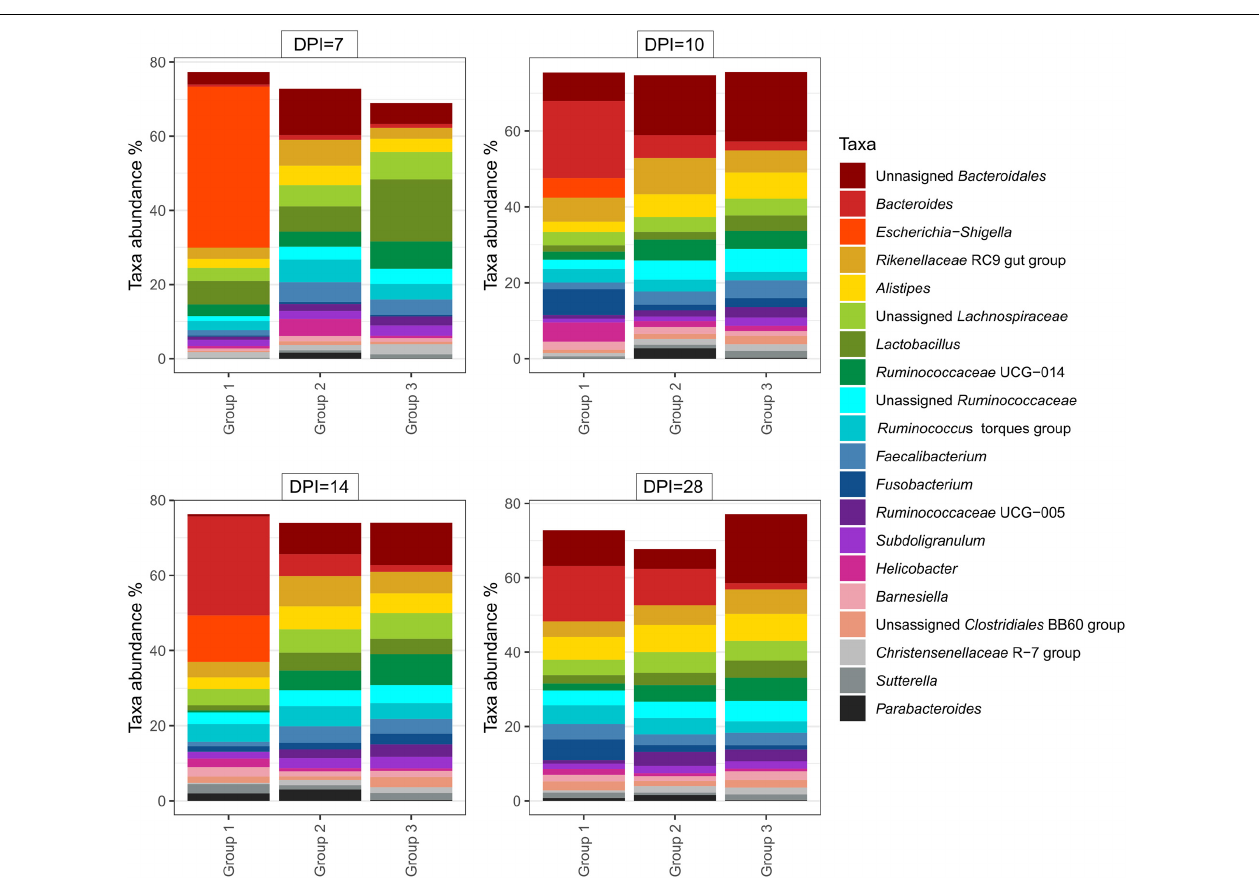
FIGURE 5 | Relative amount (%) of 20 most abundant bacterial genera in caeca of chickens from different groups and days post H. meleagridis infection (dpi). Group 1, infected with H. meleagridis + lux -tagged E. coli ; Group 2, infected with lux -tagged E. coli ; Group 3, negative